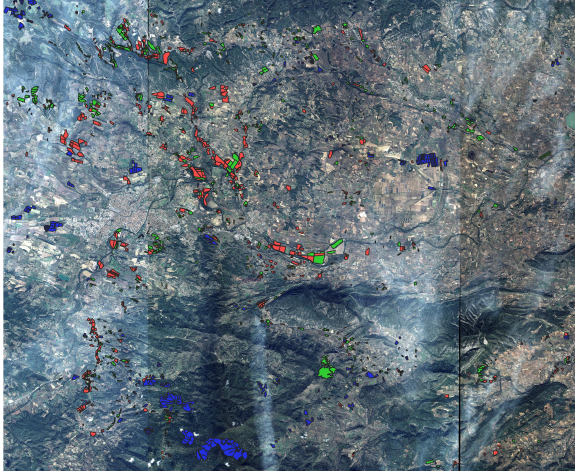
Figure 2 . Identifiable damages ( DGT and DPI , in red), unidentifiable claimed damages excluded from the study (in green) and undamaged plots ( UDPI , in blue) over Pléiades image from 2018/11/03. Aude, France.